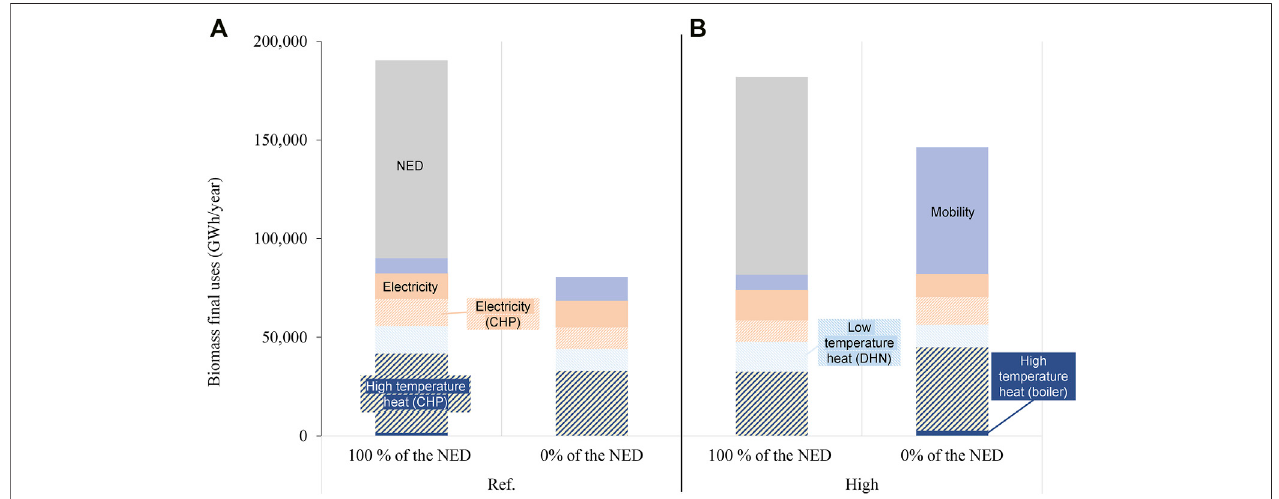
FIGURE 6 | Lignocellulosic biomass optimal uses with and without non-energy demand (NED) for cases with GHG savings of 90%, for the reference (A) and high (B) potential scenarios (CHP, combined heat and power; dec., decentralized; DHN, district heating network; NED, non-energy demand).